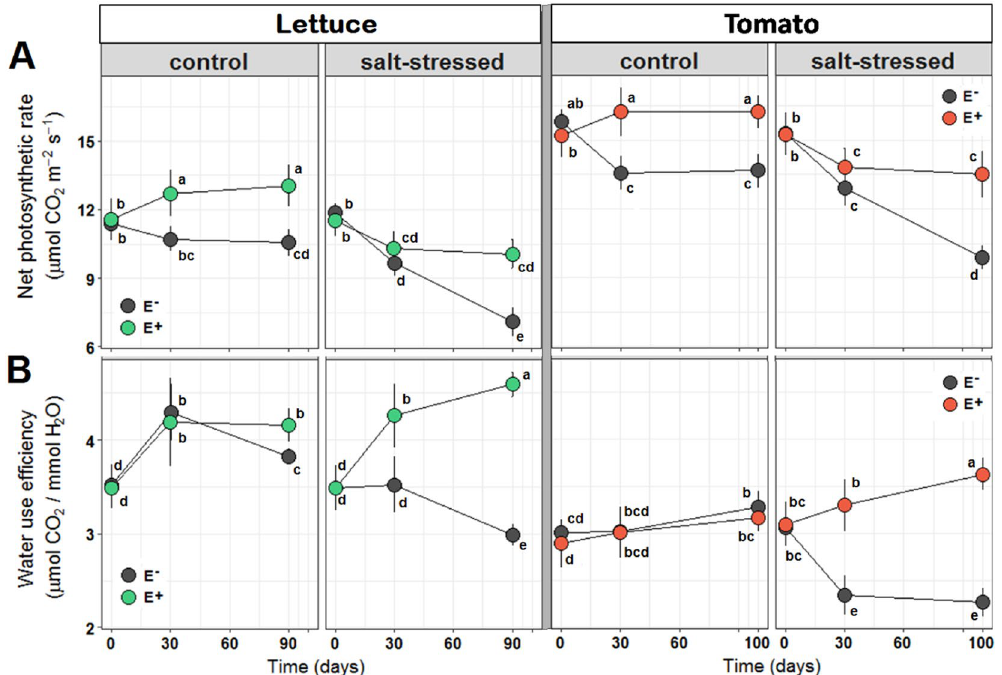
Figure 3. Effect of saline treatment (50 mM NaCl, control, vs. 150 mM NaCl, salt-stressed) and fungal inoculation (E- vs. E + ) on the net photosynthetic rate ( A max ; A) and the water use efficiency (WUE; B) of lettuce (left) and tomato (right). Different lowercase letters indicate, for each species separately, significant differences between treatments (Tukey HSD tests; α = 0.05). Values are means ± SD ( n = 20).